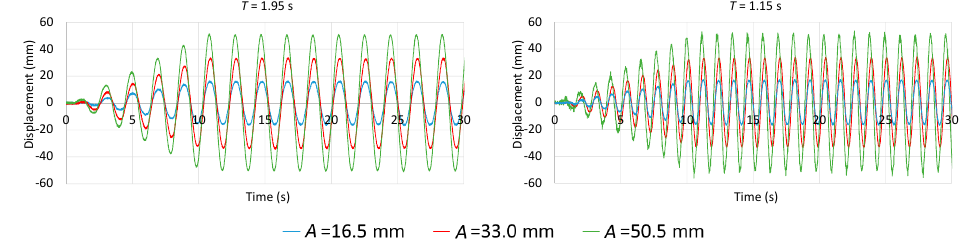
Figure 3. Measured piston motions of wave-making board.